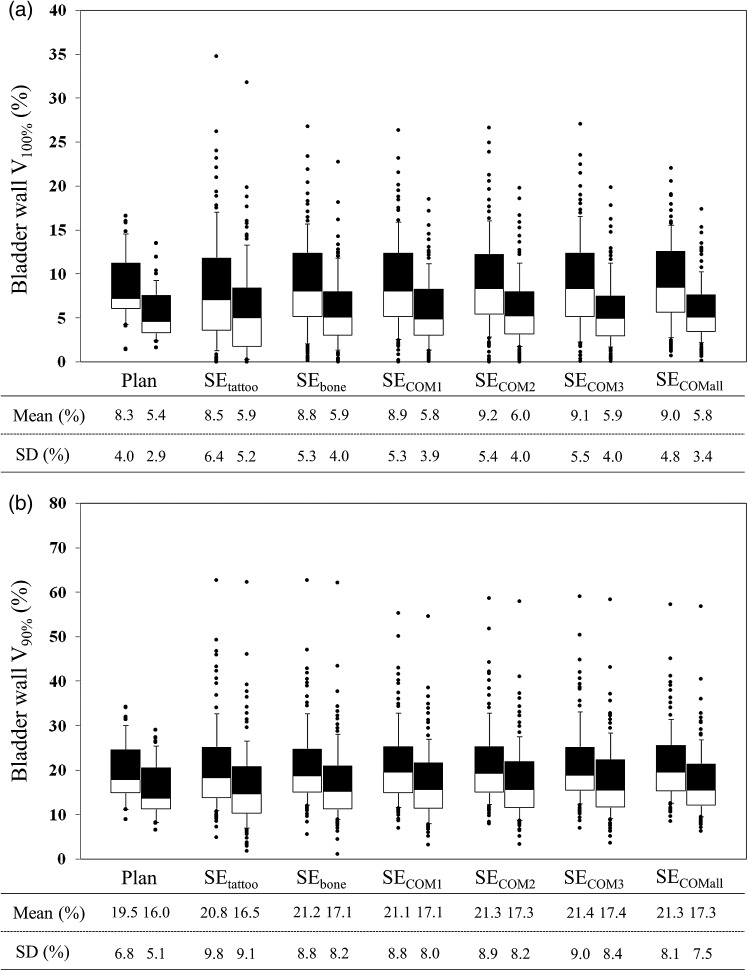
Interfractional change in bladder wall (a) V100% and (b) V90%. For each set-up correction policy, the left and right box plots show data in the PTV8/5 and PTV5/5 groups, respectively. Dose analysis parameters are graphically presented in box plots (showing medians, and 25th and 75th percentiles) with whiskers (10th and 90th percentiles); outliers are shown as dots.